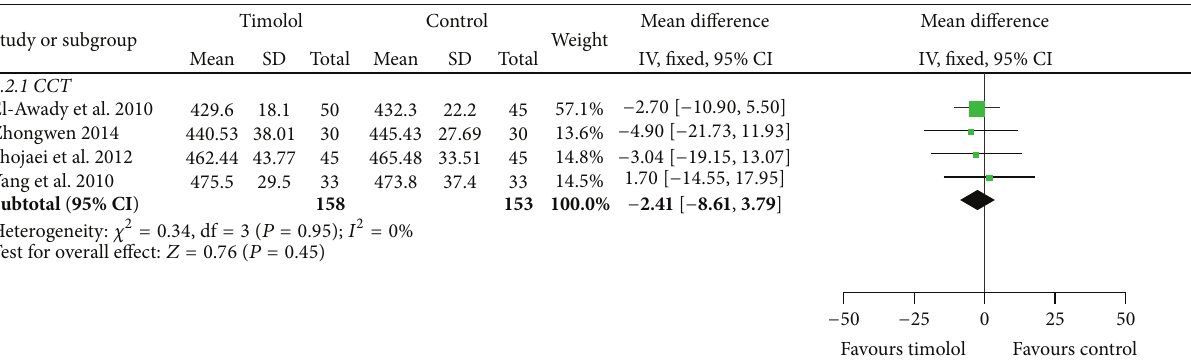
Figure 4: Comparison of central corneal thickness in patients with myopic regression after LASIK.